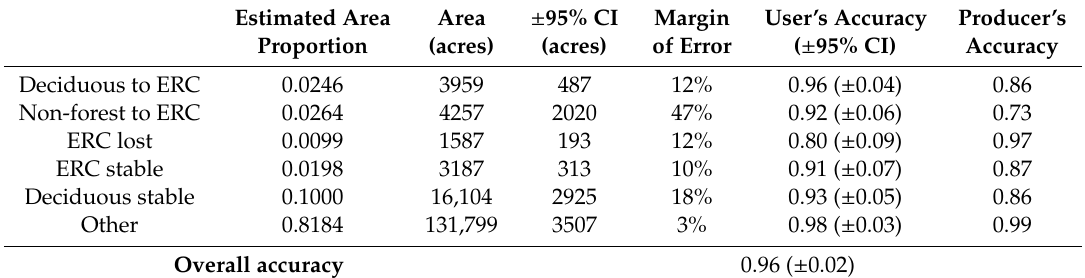
Table 3. Area estimation with 95% confidence intervals—Tuttle Creek Reservoir.